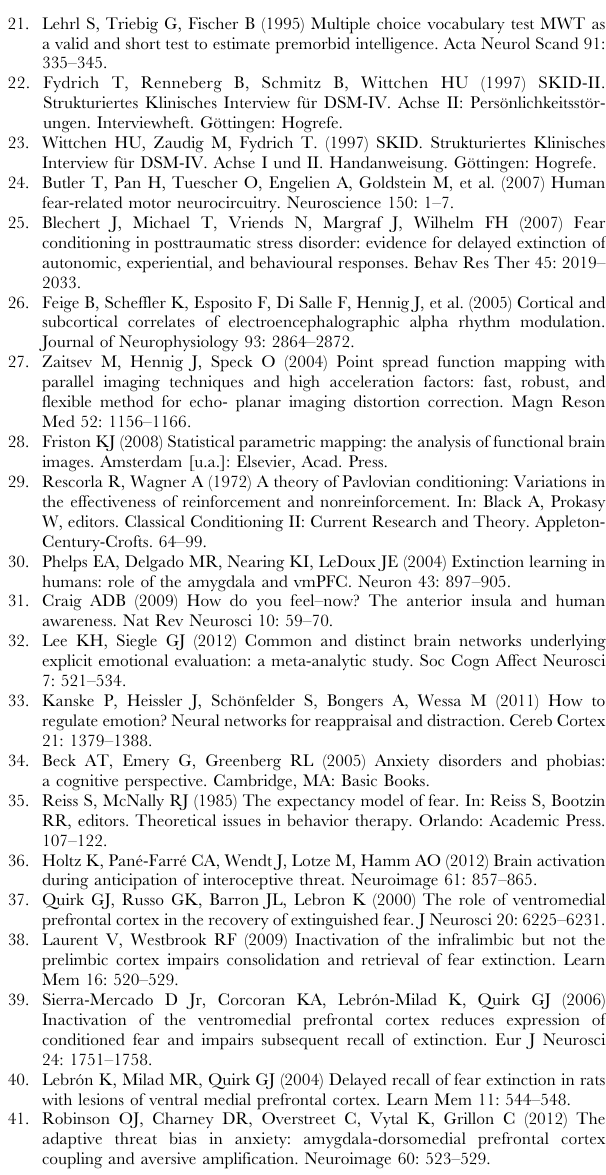
Figure S3 Instructed fear (study 1): vmPFC activation. ( A ) Contrast ‘CS 2. CS + ‘ across both test runs (IF-Test1, IF- Test2) (model 1, see Methods ). Display threshold: p , 0.001 uncorrected. Activations superimposed on a canonical structural image with the rostral dmPFC/dACC ROI depicted as a square of lighter grey. ( B ) Parameter estimates from the peak voxel, estimated separately for each test run (model 2). Error bars: s.e.m. (TIFF) Figure S4 Uninstructed fear (study 2): vmPFC activa- tion. ( A ) Contrast ‘unpaired CS 2. CS + ‘ at testing (UF-Test run). Display threshold: p , 0.001 uncorrected. Activations superim- posed on a canonical structural image with the rostral dmPFC/ dACC ROI depicted as a square of lighter grey. ( B ) Parameter